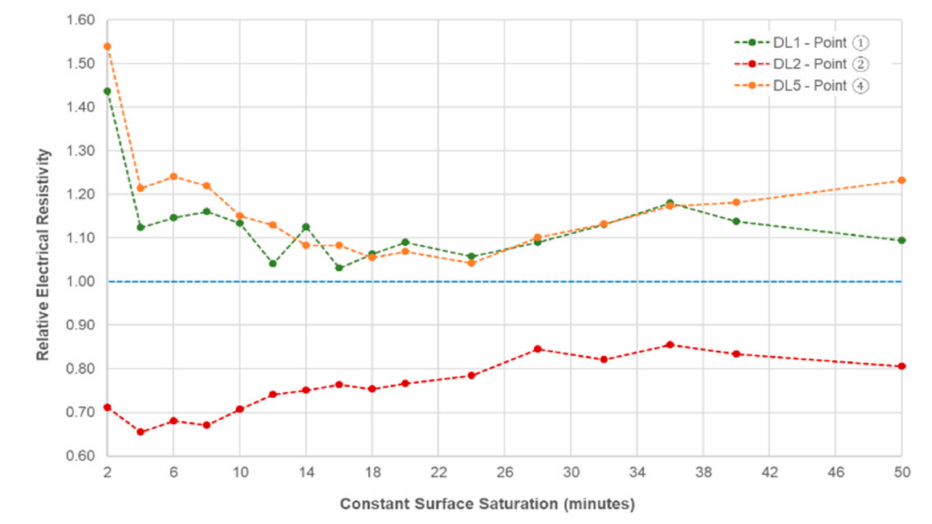
Figure 12. Relative electrical resistivity at delaminated zones with respect to continuous surface saturation in